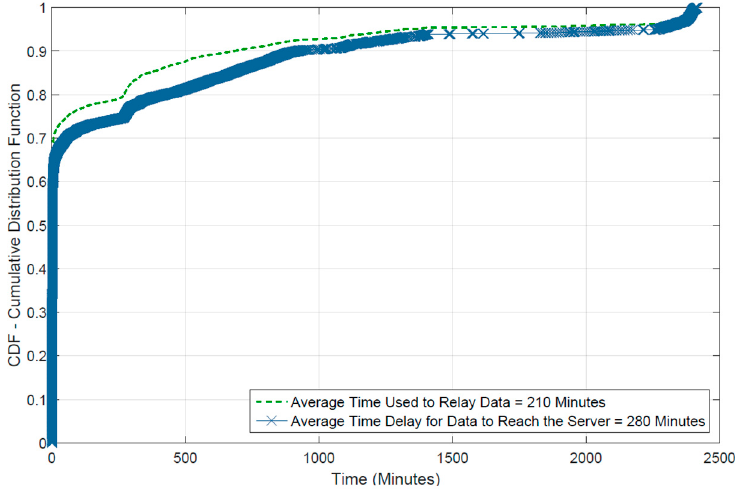
Figure 15. Time delay: single hop relay (blue) and end-to-end (green).